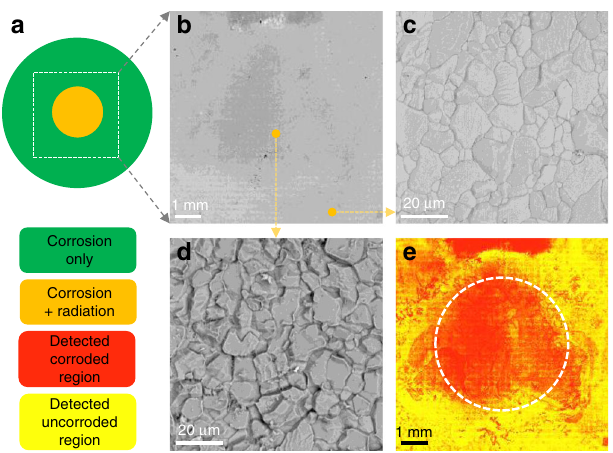
Fig. 3 Salt-facing side of pure Fe following simultaneous corrosion/ irradiation. a Location on the Fe foil used for SEM imaging. Orange represents irradiated region. Green represents unirradiated region. b SEM image of the salt-facing side after 6 h at 650 °C under 2.0 μ A cm − 2 proton irradiation. Scale bar: 1 mm. c Enlarged SEM image for the edge (unirradiated) region of the foil. Scale bar: 20 μ m. d Enlarged SEM image for the center (irradiated) region of the foil. Scale bar: 20 μ m. e Machine- learning based segmentation of b , showing auto-identi fi ed corroded (in red) and uncorroded (in yellow) regions. The white circle delineates the proton beam perimeter. Scale bar: 1 mm.